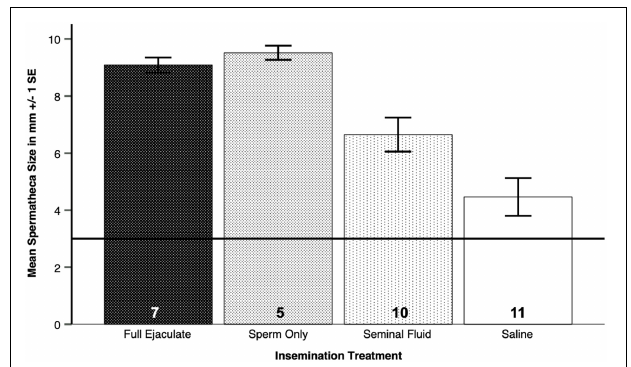
FIGURE 3 | The spermatheca sizes of surviving Atta colombica queens inseminated with either full ejaculates, sperm only, seminal fluid only or a Hayes saline solution varied widely and significantly ( Table 3A ). The horizontal line is the approximate diameter of empty spermathecae in A. colombica queens.